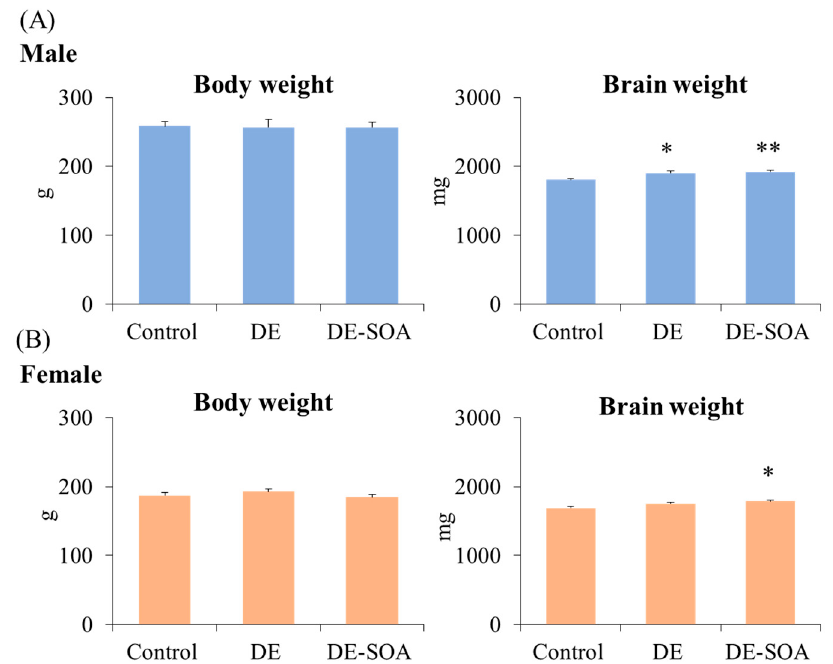
Figure 1. Assessment of overall toxicity. Body weight and brain weight in 10-week-old ( A ) male and ( B ) female rats of the control, DE- or DE-SOA-exposed groups ( n = 10, ** p < 0.01, * p < 0.05 vs. corresponding control).